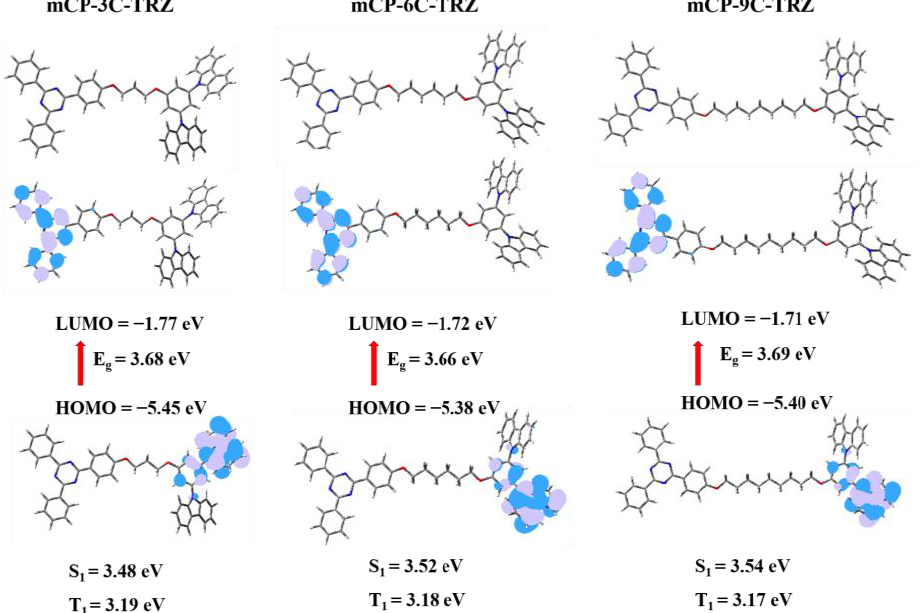
Figure 2. HOMO and LUMO distributions and 3D structure of the optimized ground state calculated by B3LYP/6-31G(d) level for mCP-3C-TRZ, mCP-6C-TRZ and mCP-9C-TRZ.